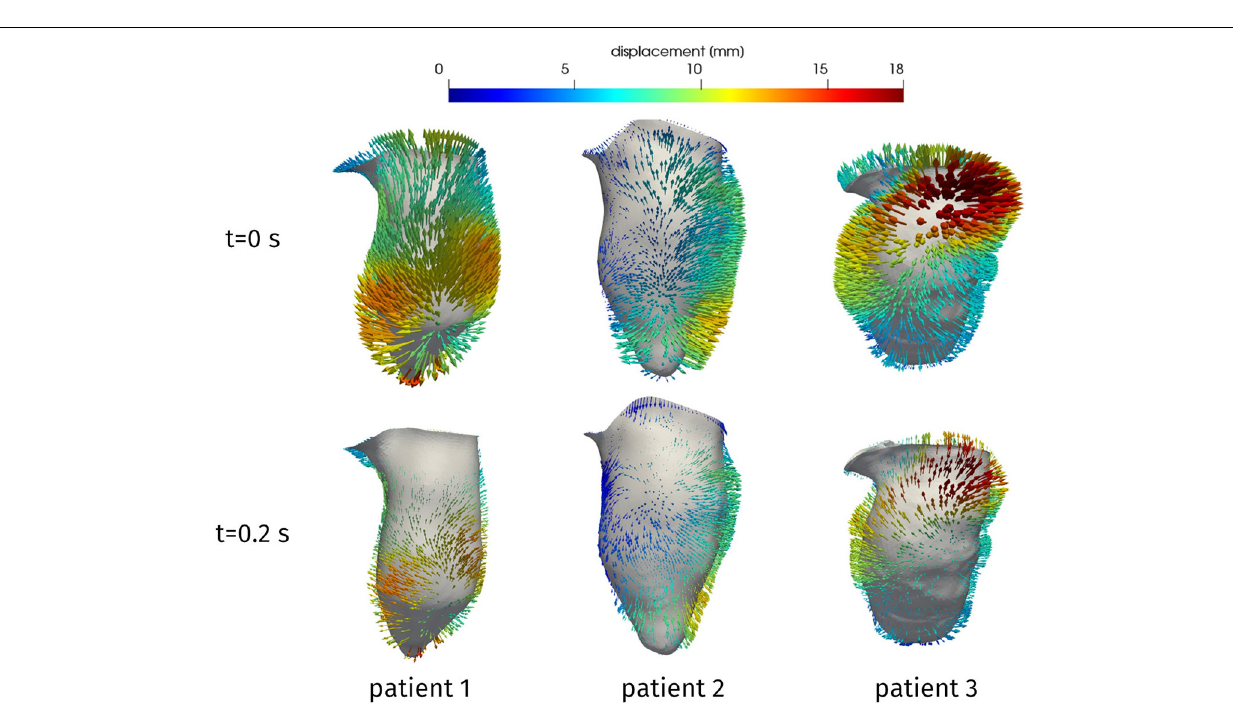
FIGURE 4 | Reconstructed displacement field of the three patients, at the end of diastole ( t = 0 s) and in late systole ( t = 0.2 s). LV aligned vertically, with septal wall on the